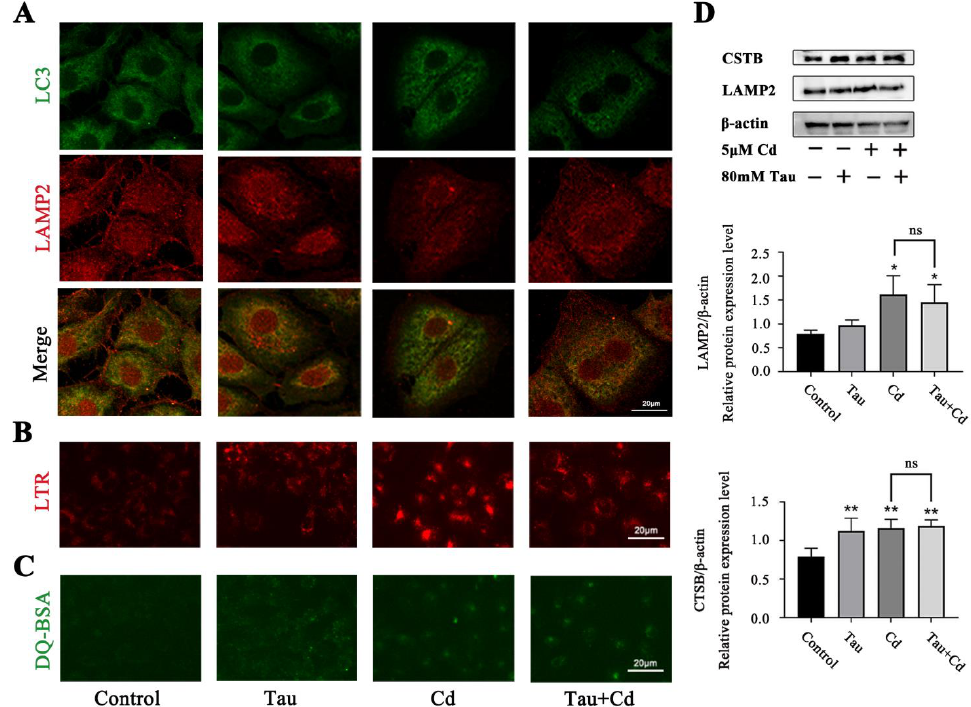
Figure 3. Tau can facilitate the union of the lysosome and the autophagosome and improve the lysosome’s capacity for acidification and degradation. ( A ) Effect of Tau and Cd on the co-localization of LC3 with LAMP2 in BRL3A cells (scale bar = 20 µ m). ( B ) Effect of Tau and Cd on lysosomal acidity in BRL3A cells (scale bar = 20 µ m). ( C ) Effect of Tau and Cd on lysosomal acidity in BRL3A cells (scale bar = 20 µ m). ( D ) Effect of Tau and Cd on the protein levels of LAMP2, CTSB in BRL 3A cells. Cells were treated with 80 mM Tau and/or 5 µ M Cd for 6 h; then, the proteins levels of Atg5 and Beclin-1 were analyzed by Western blotting. Compared with the Control group, * p < 0.05 and ** p < 0.01. Compared with the Cd − treated group, ns > 0.05.